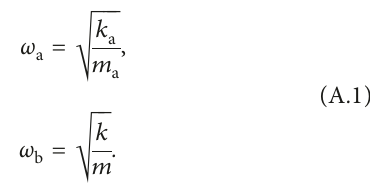
Figure 12: Measured responses to a step input (dotted) of 20 ° for the three test cases: η (solid): (a) the hub displacement and (b) the tip